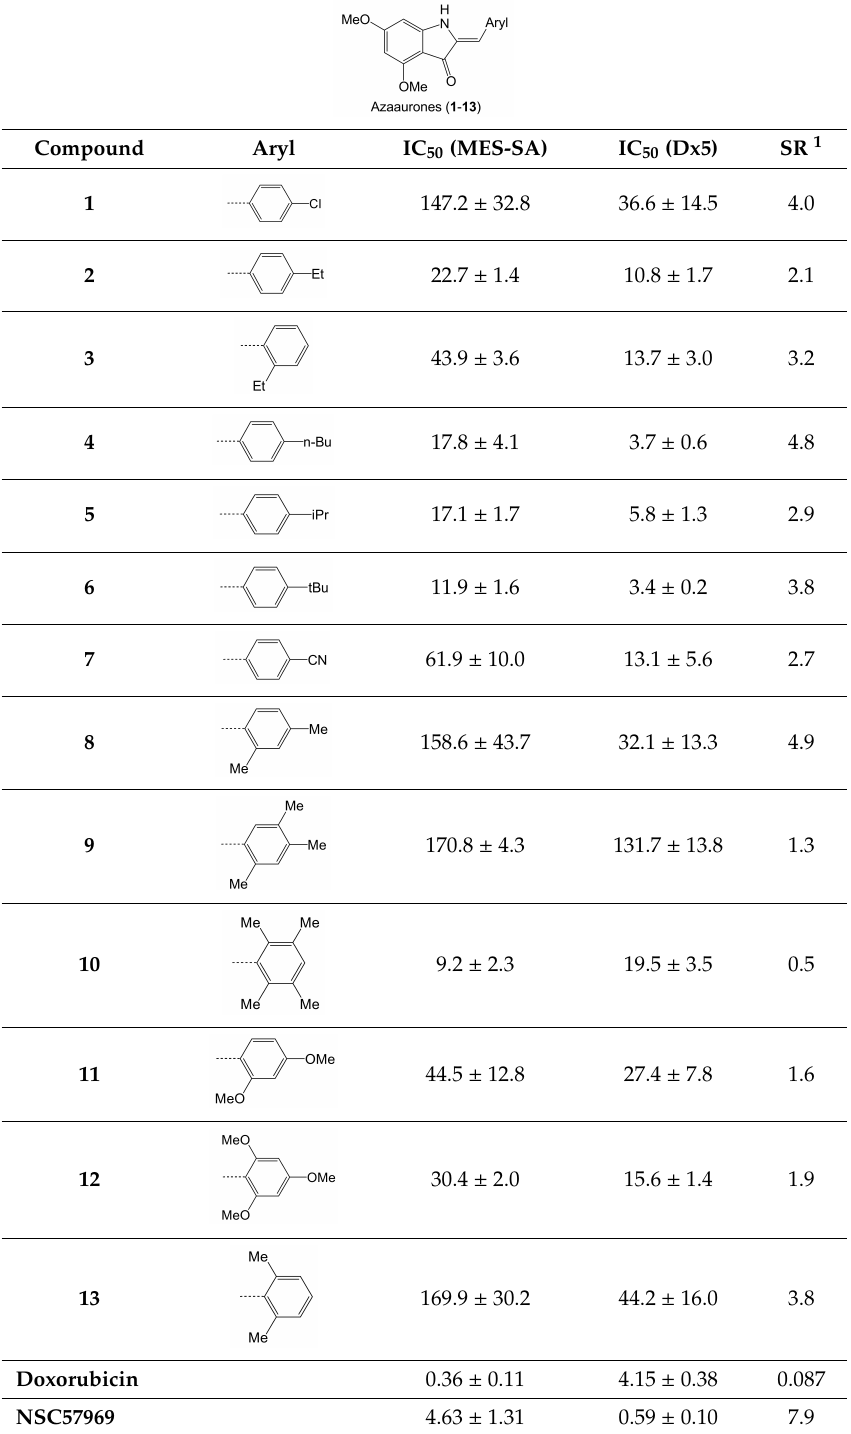
Table 1. Structures and activities of azaaurone derivatives determined from the e ff ect on the